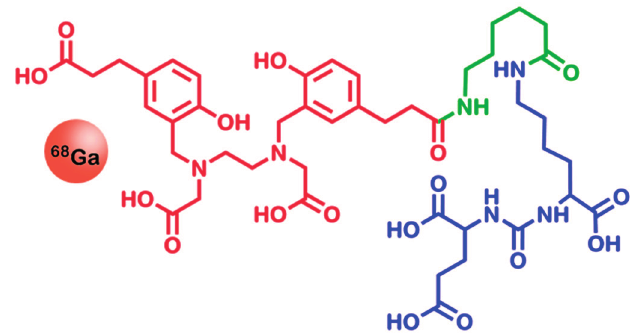
Figure 8. Chemical structure of [ 68 Ga]-PSMA-HBED-CC. The Glu-urea-Lys sequence (blue) is responsible for the targeting properties of the tracer. It is linked to the 68 Ga-labeledchelator HBED-CC (red) via an aminocaproic acid linker (green). For reasons of clarity, chelation bonds are